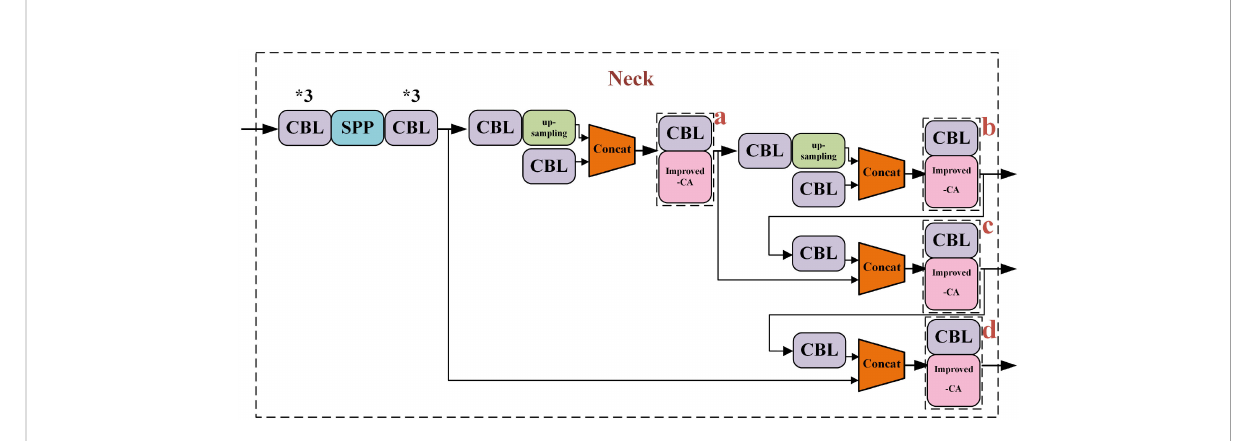
FIGURE 6 Improved combinational convolution-CA module at fusion.